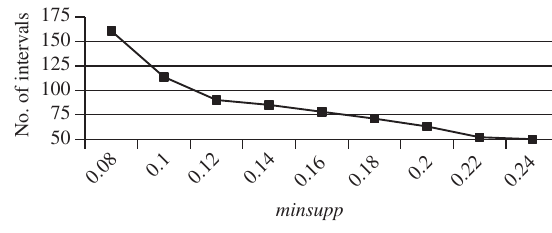
Figure 4. BMS-WebView-1 ( mininterval = 7, maxgap =